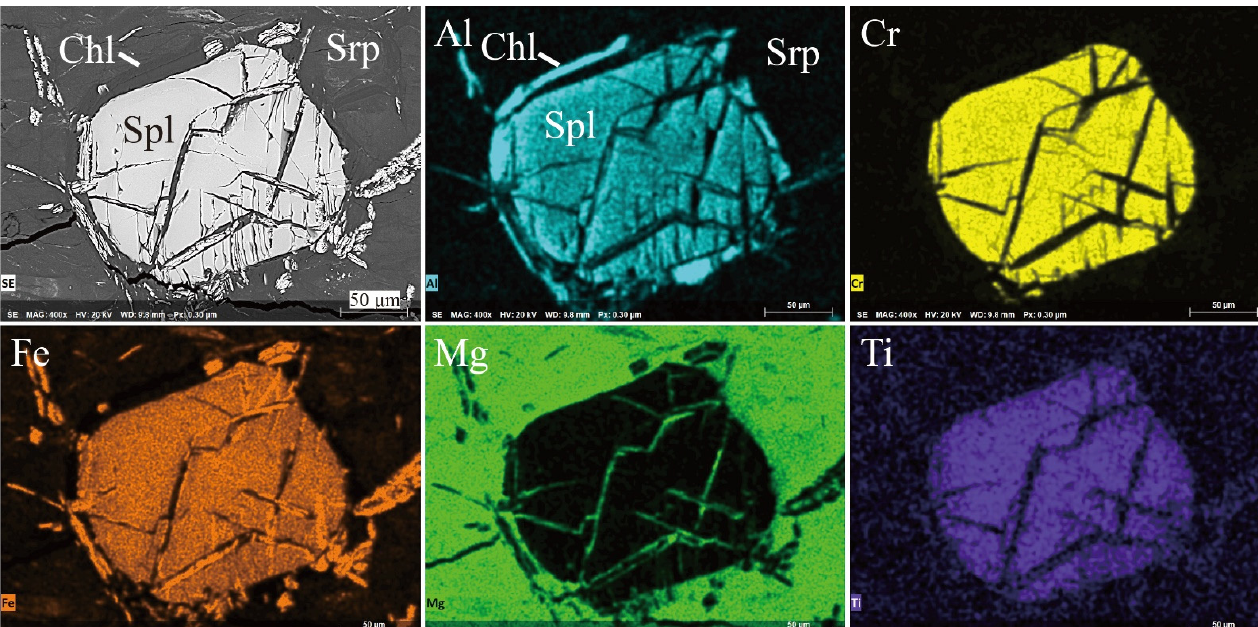
Figure 7. BSE image and multi-element mapping images of type C spinel in wehrlite. Type C spinel is cataclastic surrounded by serpentine and congested by small anhedral magnetite. It is rich in Fe 3+ in chemistry.